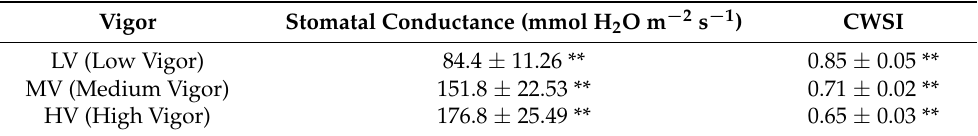
Table 4. Stomatal conductance measured at Site B for each vigor block.